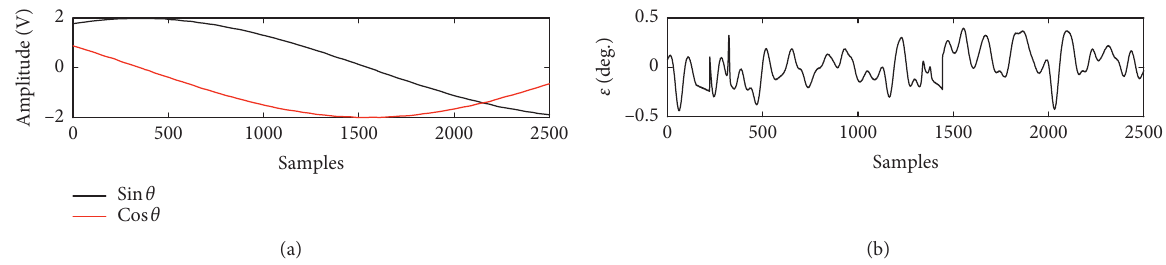
Figure 7: Simulation results using the filter and zero-crossing linearization. (a) Demodulation signals. (b) Angle